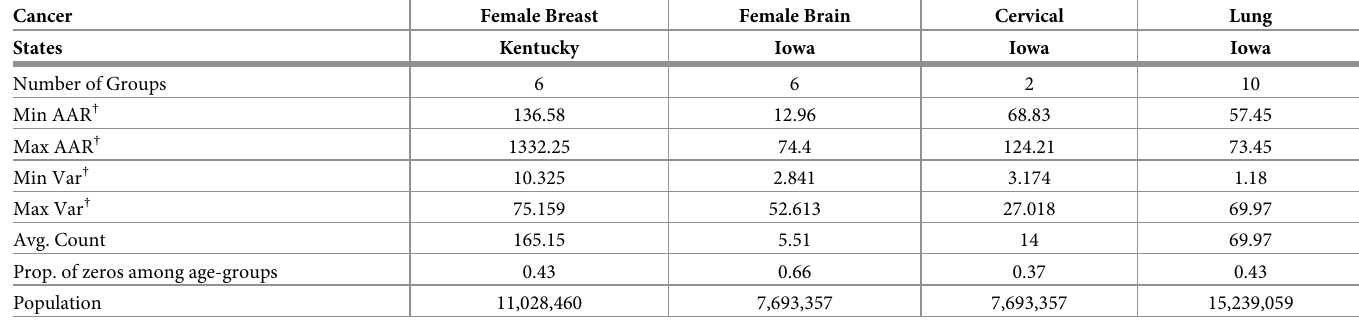
Table 1. Five years (2008 to 2012) SEER data characteristics for female breast cancer from Kentucky and female brain, cervical, lung cancer from Iowa or Kentucky are summarized based on the number of social groups, minimum and maximum of AAR, minimum and maximum variance of AAR, average event count per social group, proportion of zero event counts among age groups across J social groups, population size. Each data set consists of 19 standard age groups based on 5-year intervals. For female breast and female brain cancer, six racial/ethnic groups (Hispanic (reference), White, Black, Asian, Asian Pacific Islander, and Unknown) were used. For cervical cancer and lung cancer, two ethnic groups (Spanish Hispanic Latino and Non-Spanish Hispanic Latino (reference)) and ten groups based on household deciles income in 2008 (the lowest decile group is the reference) were used,